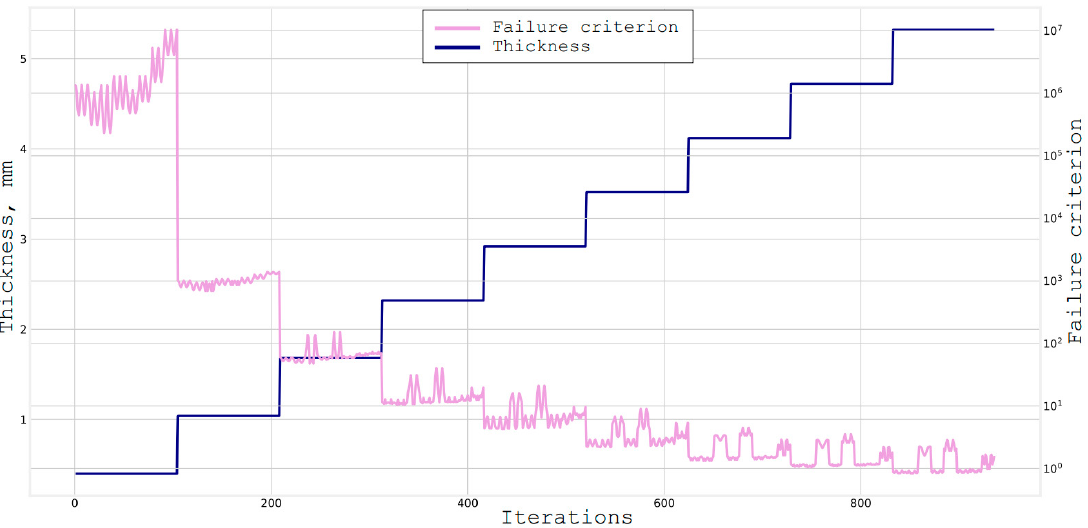
Figure 9. Full search through the unit materials and angles with step of 15 deg, and a thickness = 4.92 mm 412 sec.